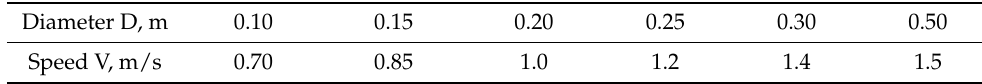
Table 1. Transportation rates of coal–water suspensions (beginning).